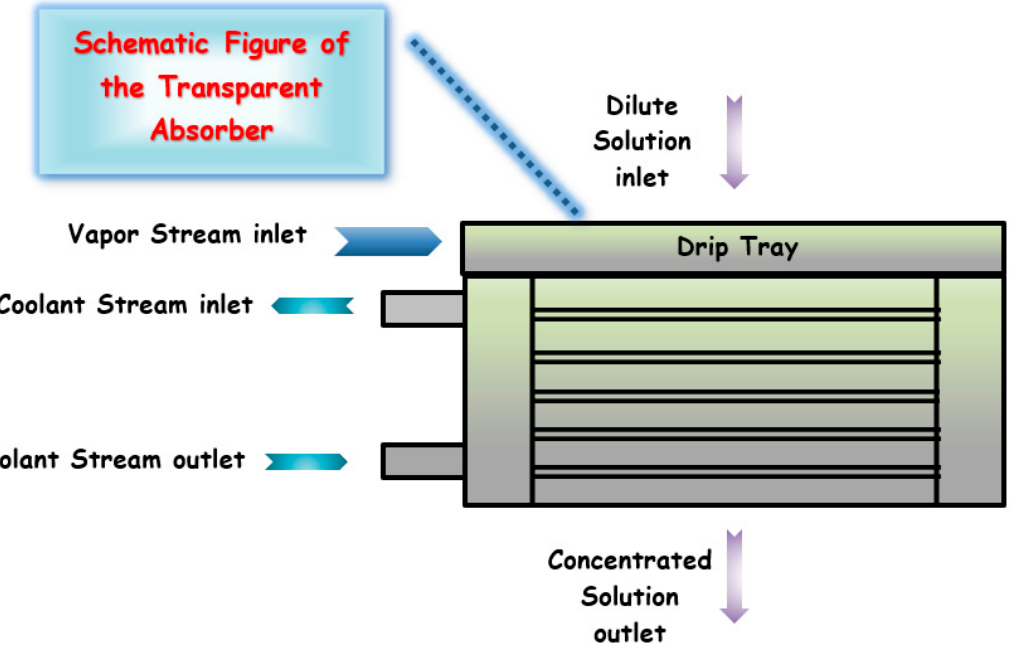
Figure 9. Absorber assembly and tube array.